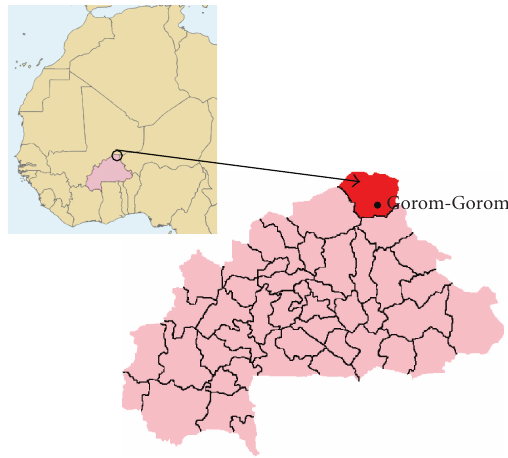
Figure 1: BurkinaFaso, Oudolan